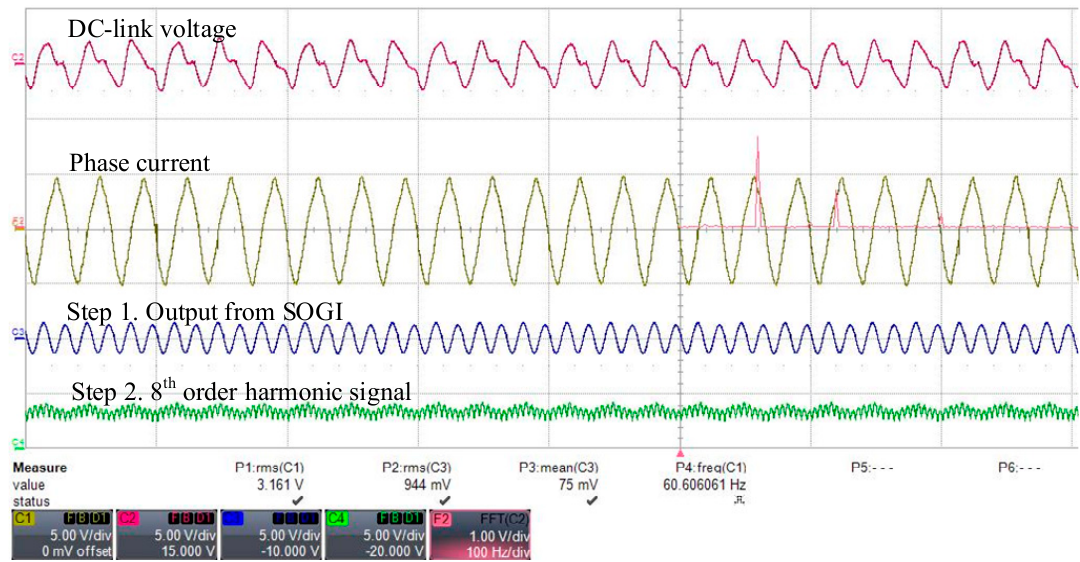
Figure 10. Steady state experimental results of a single-phase grid-tied inverter system.